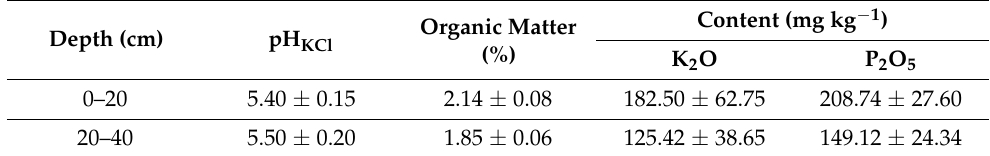
Table 1. Agrochemical indicators of the experimental